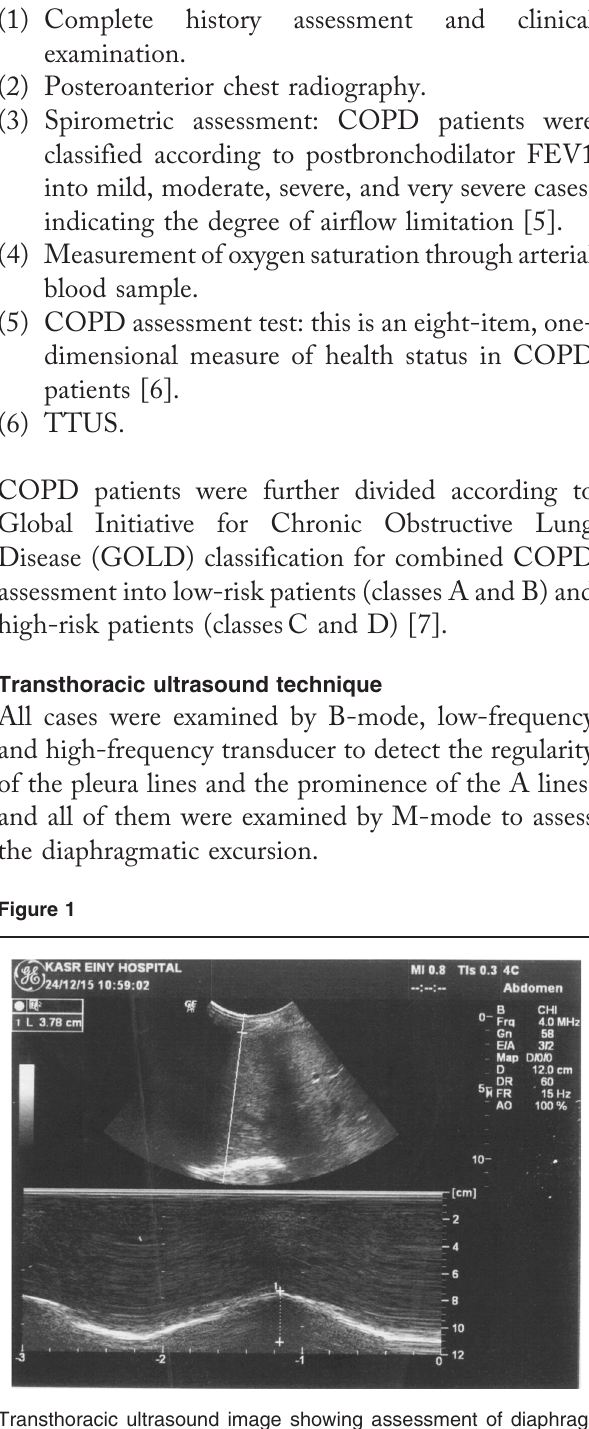
Transthoracic ultrasound image showing assessment of diaphrag- matic